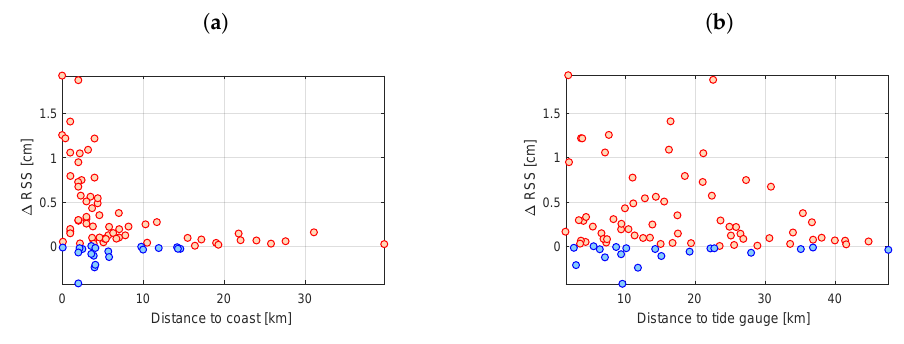
Figure 7. Difference of RSS against distance to coast ( a ) and tide gauge ( b ) in km. The values are shown for the closest nodes to the tide gauge of